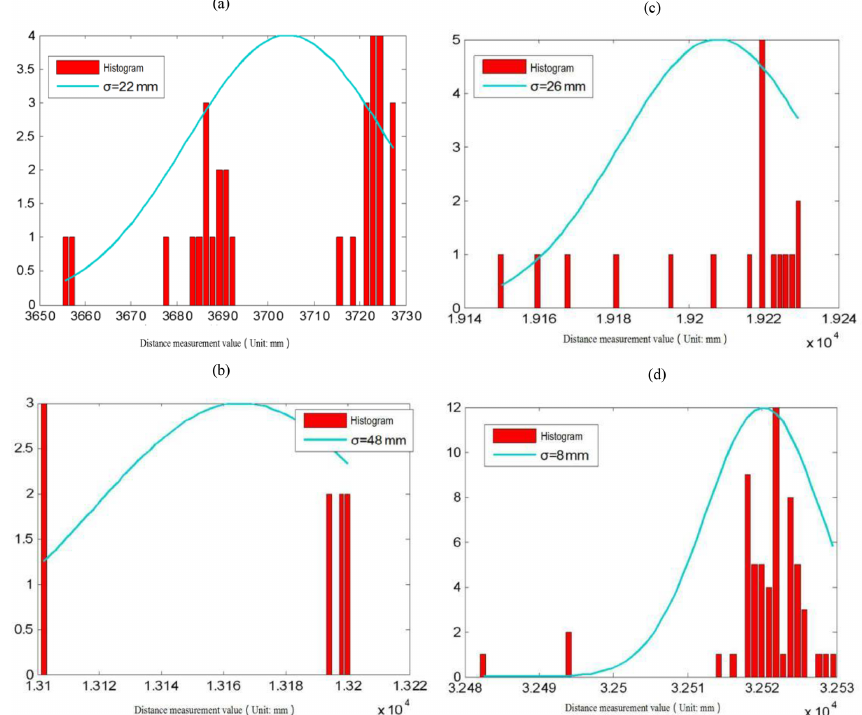
Figure 7. Statistical results after removing abnormal value. (a) The result of rejecting abnormal value at 3600mm. (b) The result of reject- ing abnormal value at 11400mm. (c) The result of rejecting abnormal value at 19200mm. (d) The result of rejecting abnormal value at 31800mm.